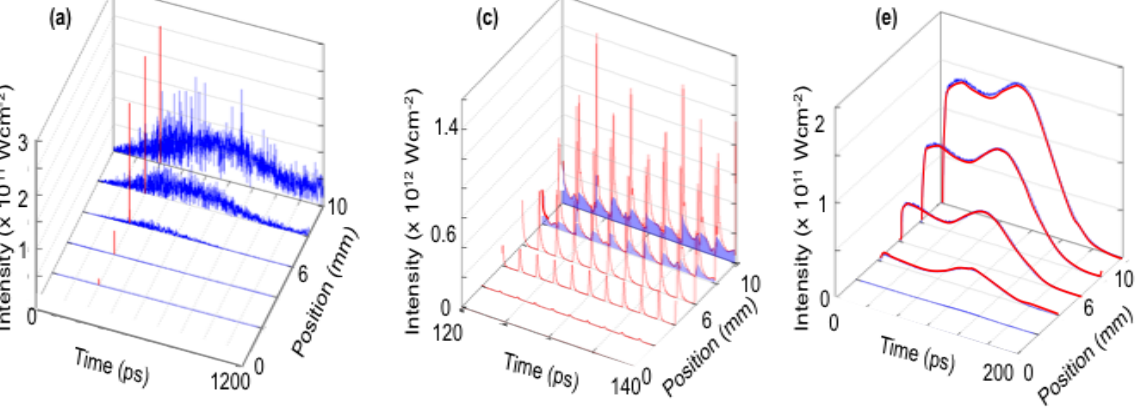
Figure 6. Intensity of the amplified HHG (red) and ASE (blue) at different plasma lengths in ( a ) Ditmire’s experiment; ( b ) when seeding a train of 100 HHG (only ten HHG are shown); and ( c ) when a stretched HHG matching the duration of the gain is seeded into the